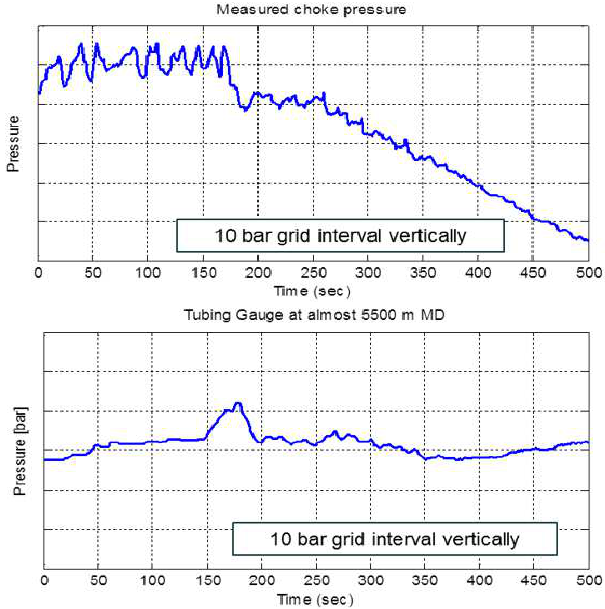
Figure 2: Measured choke pressure and downhole tub- ing pressure shortly above the open